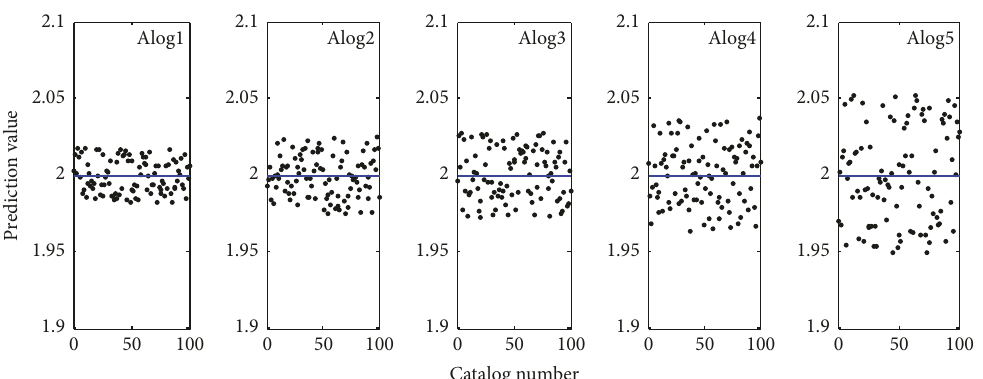
Figure 4: Prediction result for state 1.